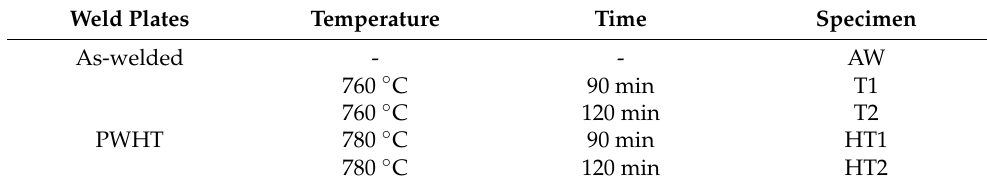
Table 3. Post-weld heat treatment (PWHT) parameters.